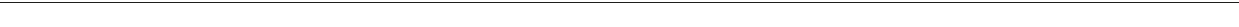
Fig. 1 BMI1 knockdown inhibits AR signaling and BMI1 interacts with AR-NTD. a Protein levels following BMI1 depletion using two independent siRNA strands targeted at BMI1 (siBMI1 #1, siBMI1#2) in C4-2 cells (top panel) and 22Rv1 cells (bottom panel). b Transcript levels of AR and its target genes in C4-2 (top panel) and 22Rv1 cells (bottom panel) post BMI1 depletion were quanti fi ed by quantitative PCR, * P < 0.05 vs. Scramble (normalized to β -actin mRNA, mean ± SEM, n = 3). c , d Immunoprecipitations of C4-2 ( c ) and 22Rv1 cells ( d ) using anti-AR, anti-BMI1, or anti-RING1B antibody, rabbit IgG